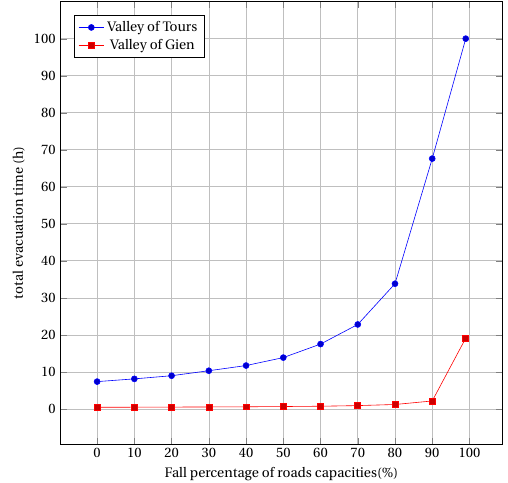
Figure 19. Construction of the evacuation plan 125h after the be- ginning of the floor: evacuation scenarios in case of fall of network